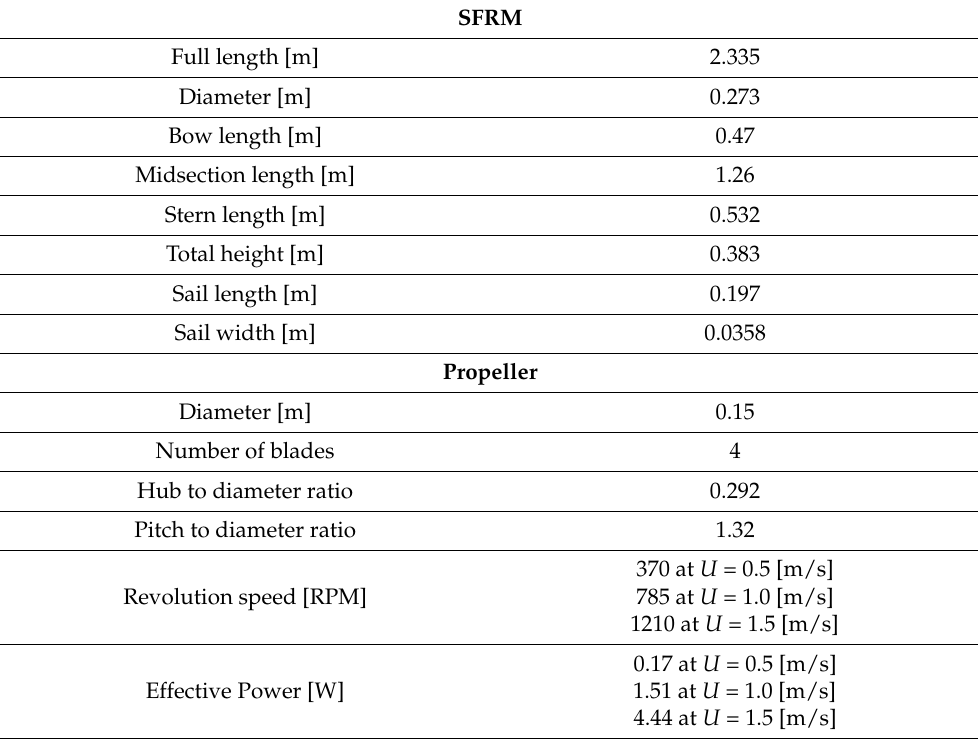
Figure 1. ( a ) Side, and ( b ) rear view of the submarine free-running model (SFRM). Table 1. Principal particulars of the SFRM and the